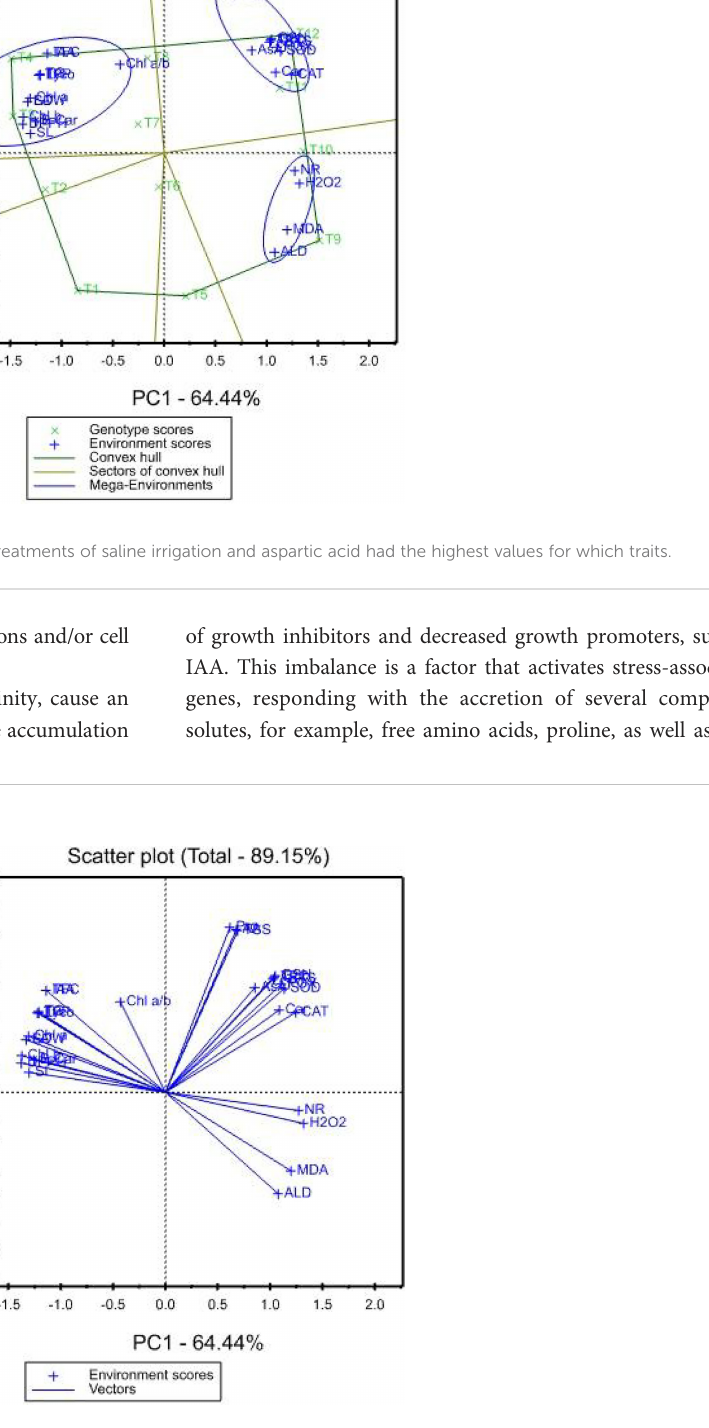
FIGURE 4 Vector view of TT biplot showing the interrelationship among measured traits of the wheat